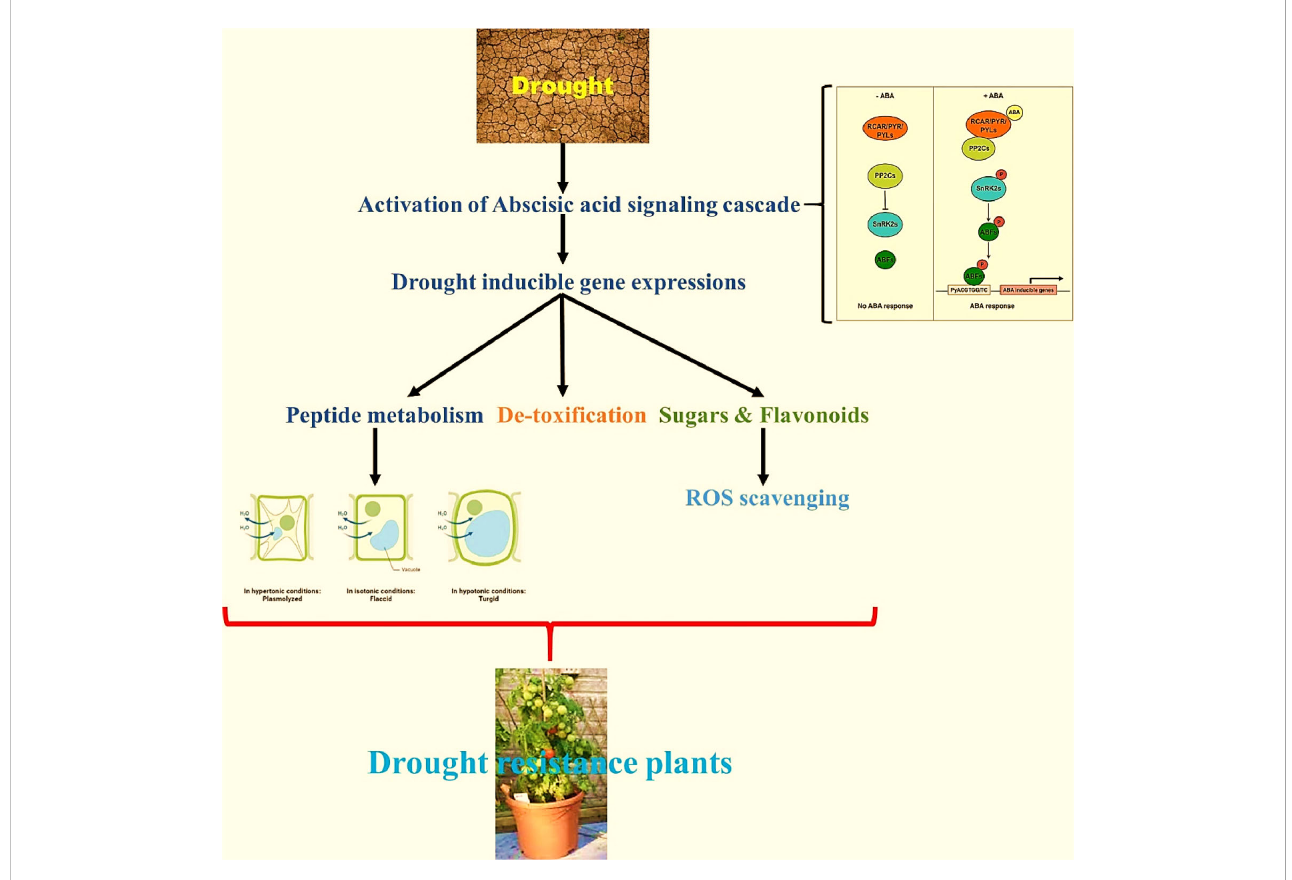
FIGURE 6 Research outcome in using Abscisic acid as drought resistance enhancer